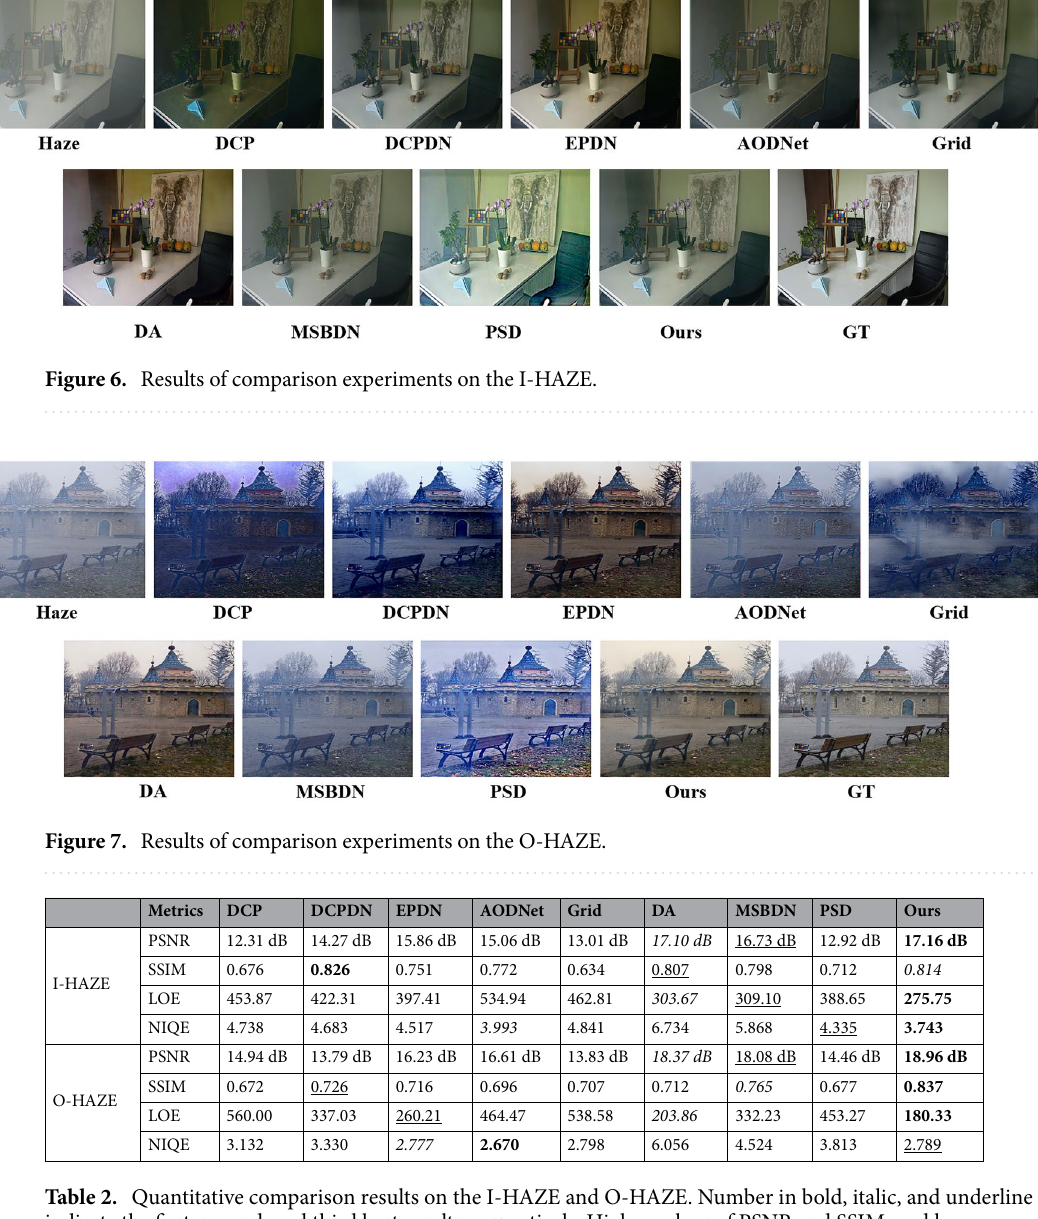
Table 2. Quantitative comparison results on the I-HAZE and O-HAZE. Number in bold, italic, and underline indicate the first, second, and third best results, respectively. Higher values of PSNR and SSIM; and lower values of LOE and NIQE represent better